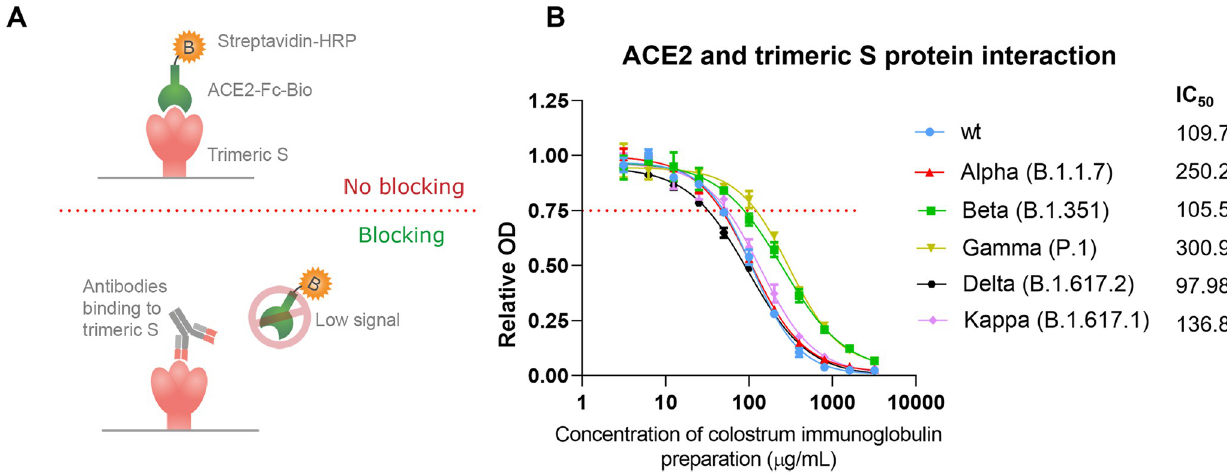
Fig 2. (A) NAb ELISA setup and principle. Colostrum immunoglobulin preparation was added in serial dilution to the trimeric S protein-coated plates and preincubated to provide some time for the antibodies to bind. Next, conjugated ACE2, which competes with the antibodies for the same binding sites, was added. Color development becomes more intense in samples containing fewer neutralizing antibodies, and a sample without any antibodies has the most intense color since maximal binding of conjugated ACE2 could occur. (B) Binding of colostrum immunoglobulin to the different trimeric S protein variants in SARS-CoV-2. Relative optical density (OD) values are represented as the mean ± SD (n = 3). The IC 50 concentrations for colostrum immunoglobulin preparation were determined using 4-parameter nonlinear